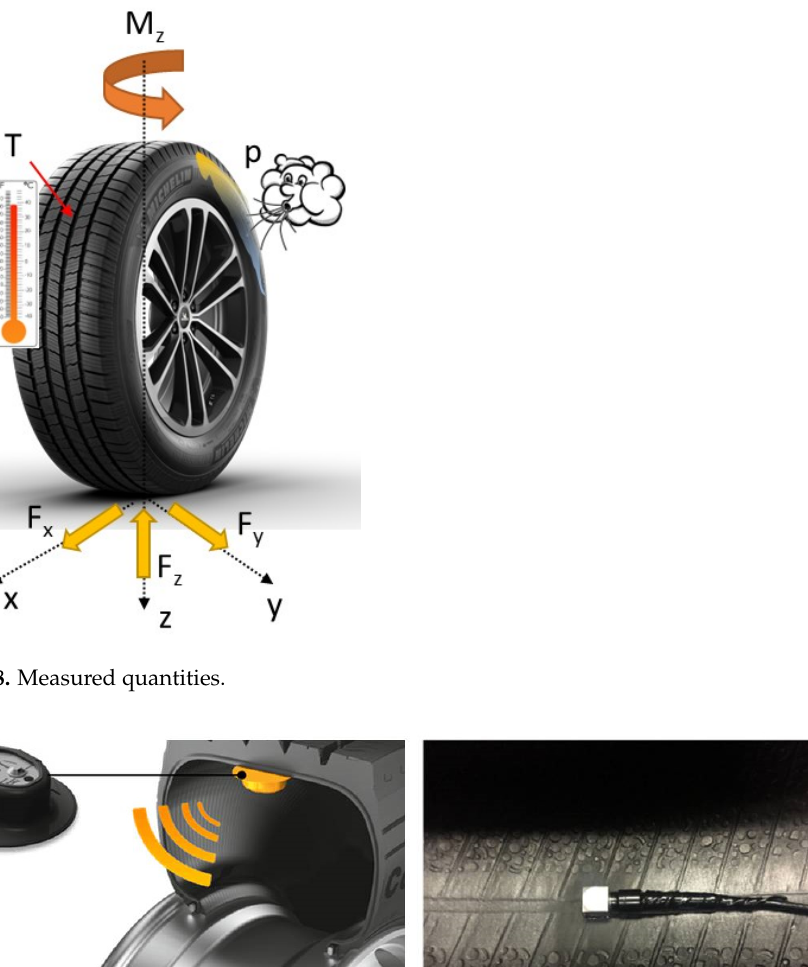
Figure 9. Typical examples of ( a ) adhesive tire sensors and ( b ) adhesive tread sensors (tri-axial ac- celerometer).